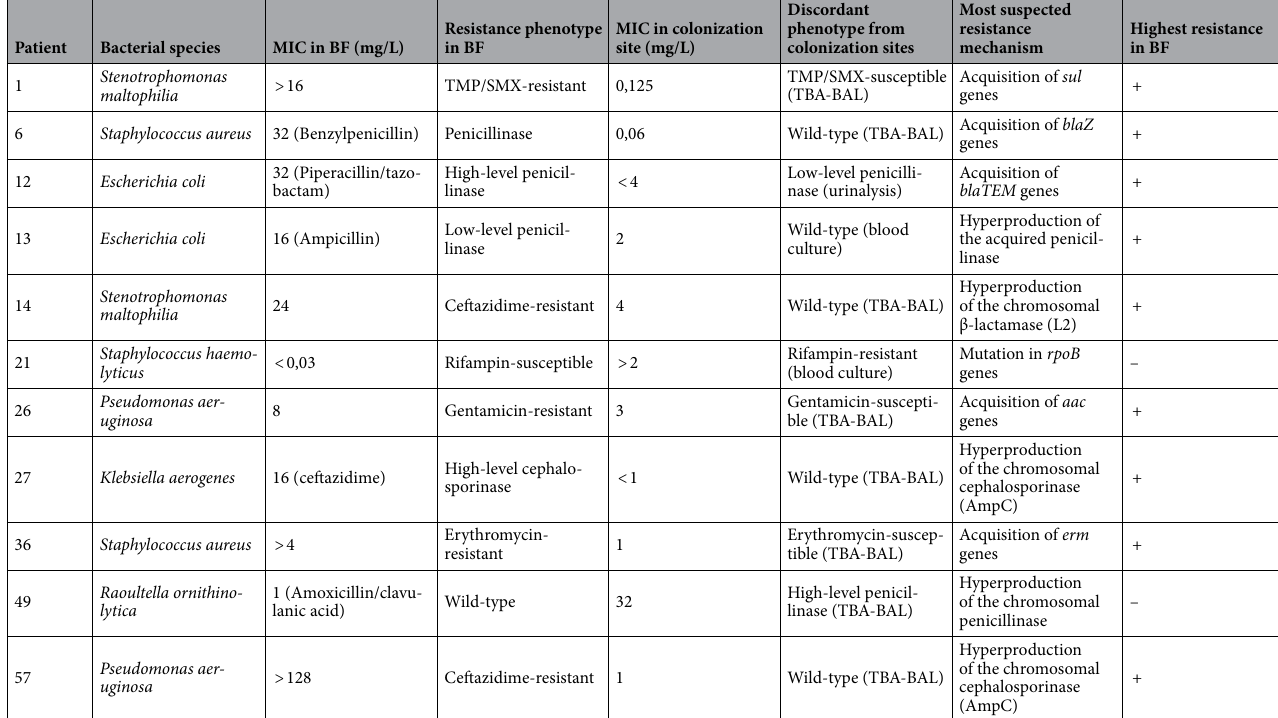
Table 2. Comparison of discordant antibiotic resistance phenotypes between ETT-deposited BF and colonization/infection sites for eleven patients. BAL bronchoalveolar lavage, BF biofilm, TBA tracheobronchial aspirate, TMP/SMX